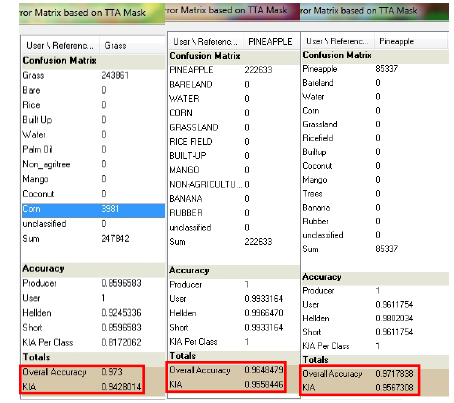
Figure 9. Error Matrix based on TTA Mask (Laguindingan, Gitagum, and